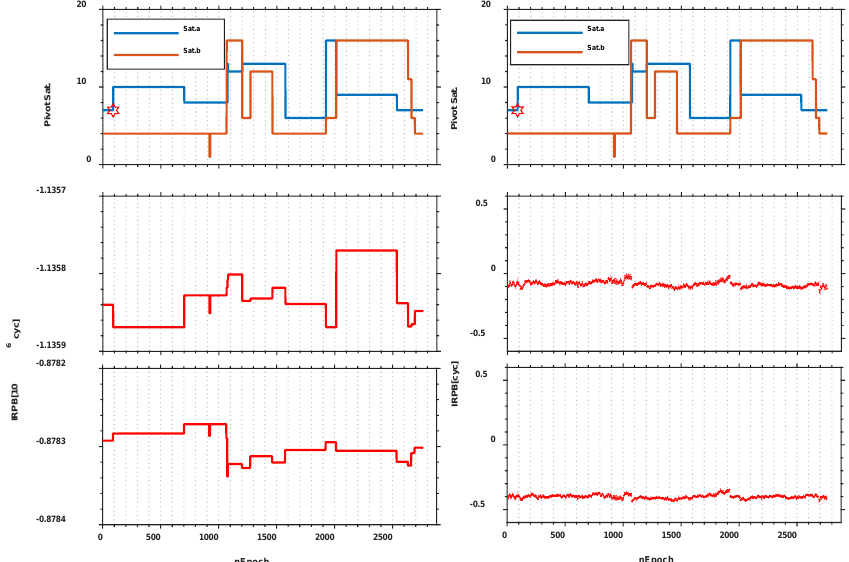
Figure 3. 24 h-time series of estimation results with Septentrio PolaRx5 receivers. The panels from left to right are the inter-receiver phase bias (IRPB) before and after eliminating the jumps. The subplots from top to bottom correspond to pivot satellites visibility, IRPB at B1 and B2 frequency, respectively. The single differenced ambiguities belonged to Sat.a and Sat.b form the ambiguity Nab, which is coupled in the IRPB. As an example, the hexagram marker specifies the time to alter.